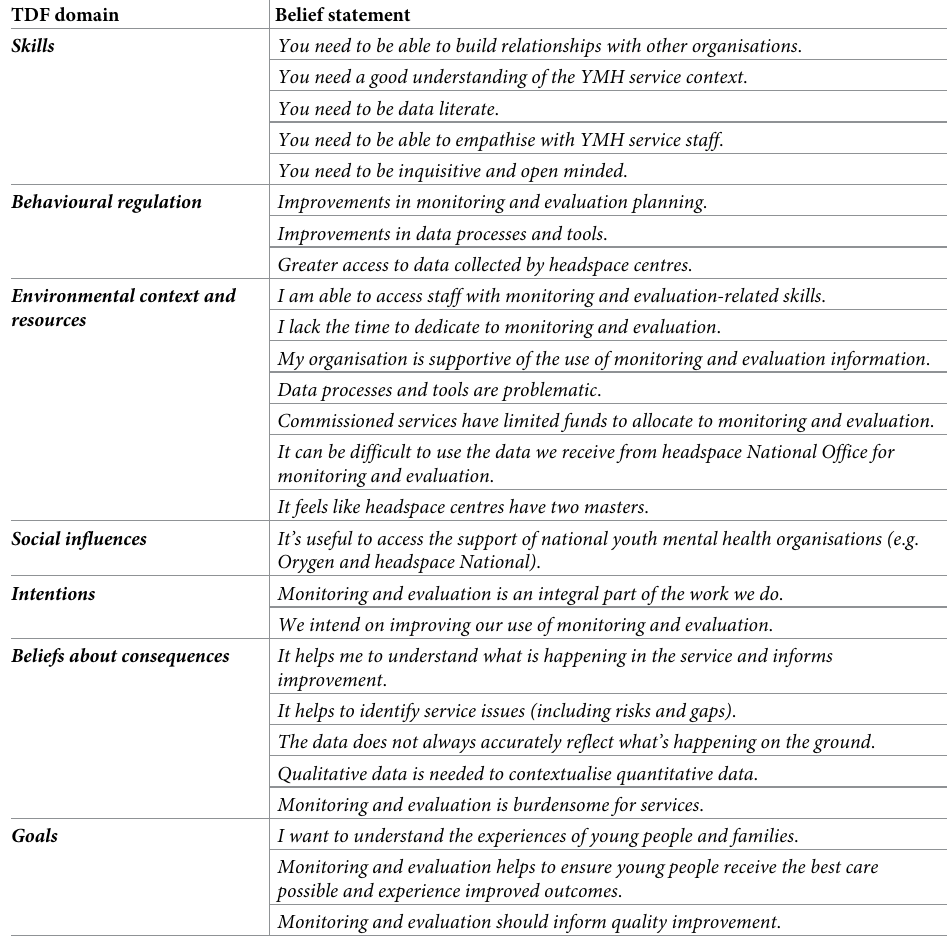
Table 4. Belief statements shared by healthcare commissioners and YMH